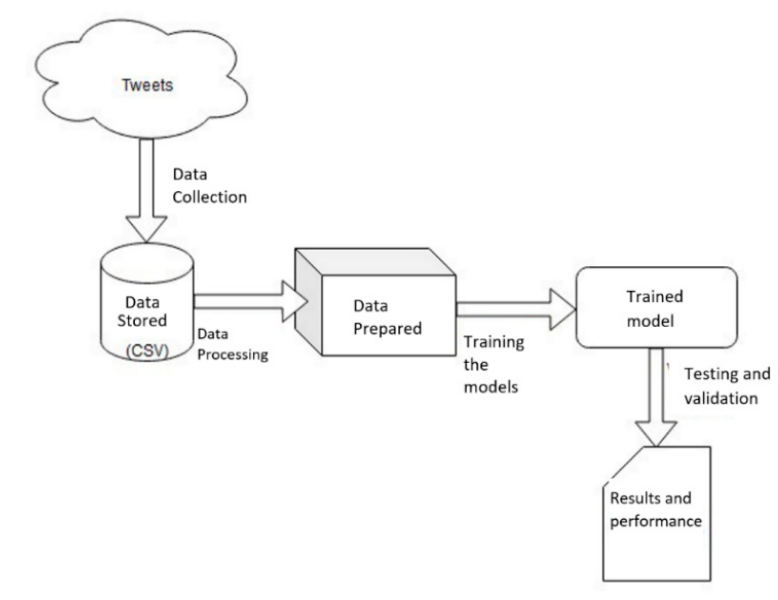
Figure 1. The four development steps for the